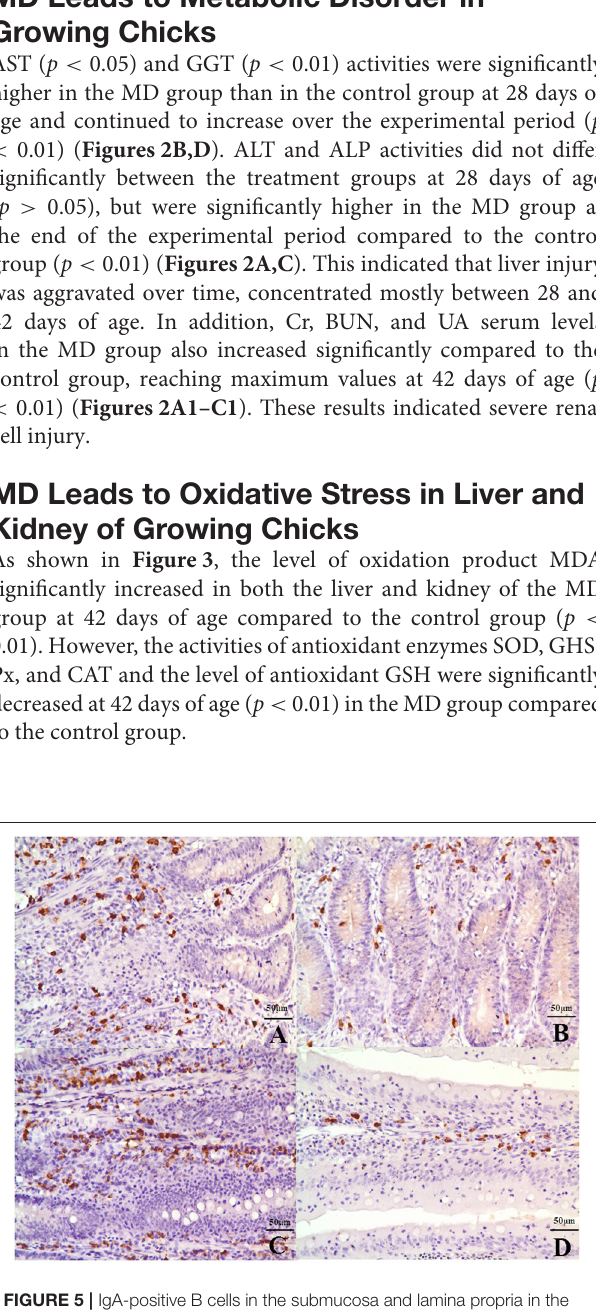
FIGURE 5 | IgA-positive B cells in the submucosa and lamina propria in the villi of the ileum at 42 days of age. (A) The ileac submucosa of the control group (400 × , bar = 50 µ m). (B) The quantity of B cells in the ileac submucosa of the MD group was significantly decreased (400 × , bar = 50 µ m). (C) The lamina propria in the villi of the ileum in the control group (400 × , bar = 50 µ m). (D) The quantity of B cells in the lamina propria in the villi of the ileum in the MD was significantly decreased (400 × , bar = 50 µ m). MD, methionine